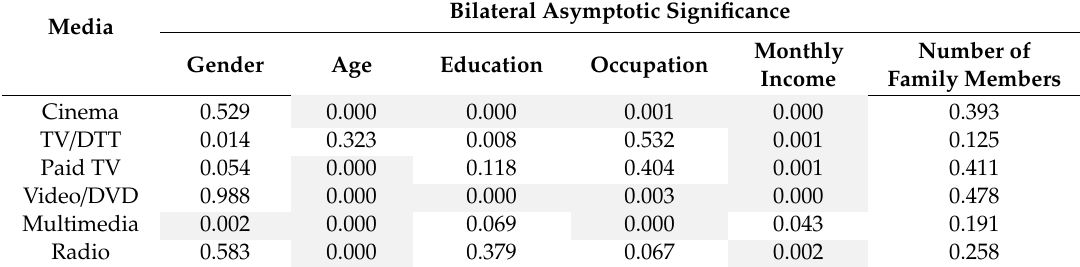
Table 4. Pearson’s chi-square tests between means of accessing audio-visual content and sociodemographic variables.